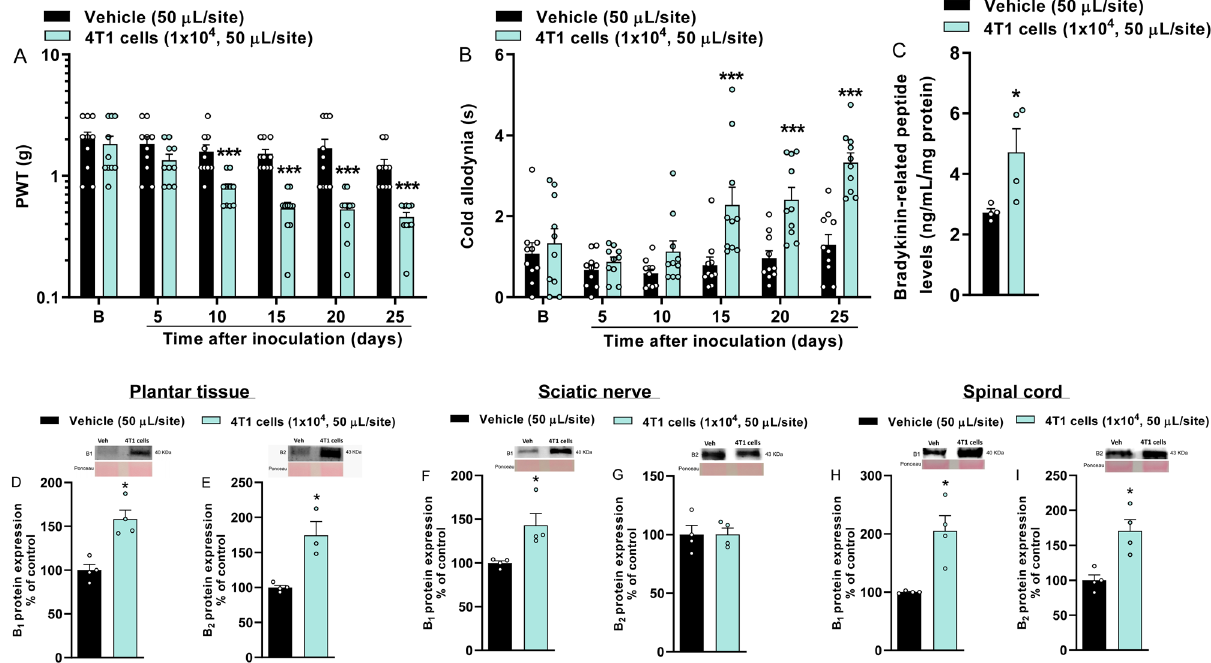
Figure 4. Metastatic breast tumor-bearing mice develop mechanical ( A ) and cold ( B ) allodynia and present increased bradykinin levels and kinin B 1 and B 2 receptor protein expression. The nociceptive parameters were evaluated at 5, 10, 15, 20, and 25 days after vehicle (50 µL/site) or 4T1 breast cancer cells (10 4 cells, 50 µL/site) injection. (B) denotes baseline mechanical threshold/nociception time before injection. Bradykinin-related peptide levels in the plantar tissue ( C ). Representative images of kinin B 1 and B 2 receptor protein expression in the plantar tissue ( D , E ), in sciatic nerve ( F , G ), and spinal cord ( H , I ) at 20 days after vehicle (50 µL/site) or 4T1 breast cancer cells (1 × 10 4 , 50 mL/site) injection. Data are expressed as the mean + SEM. *P < 0.05; ***P < 0.001 when compared to the vehicle group; two-way repeated-measures ANOVA followed by Bonferroni’s post hoc test to the behavioral tests (n = 10/group; BALB/c mice) or Student’s t-test to the protein expression and kinin levels (n = 4/group; BALB/c mice). PWT paw withdrawal threshold. The original western blot images are available in Supplementary Fig.